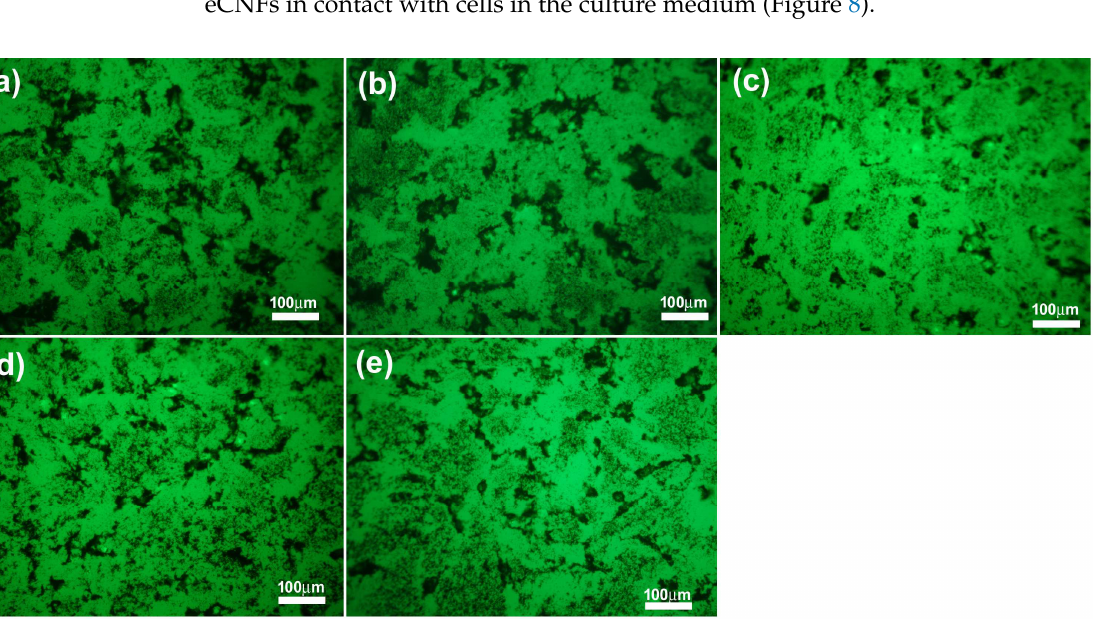
Figure 8. Fluorescence micrographs for ( a ) eCNF750, ( b ) eCNF100, ( c ) eCNF1500, ( d ) eCNF1750 and ( e ) eCNF2000 showing the behavior of fragmented eCNFs in the culture medium forming agglomerates of various shapes and sizes.